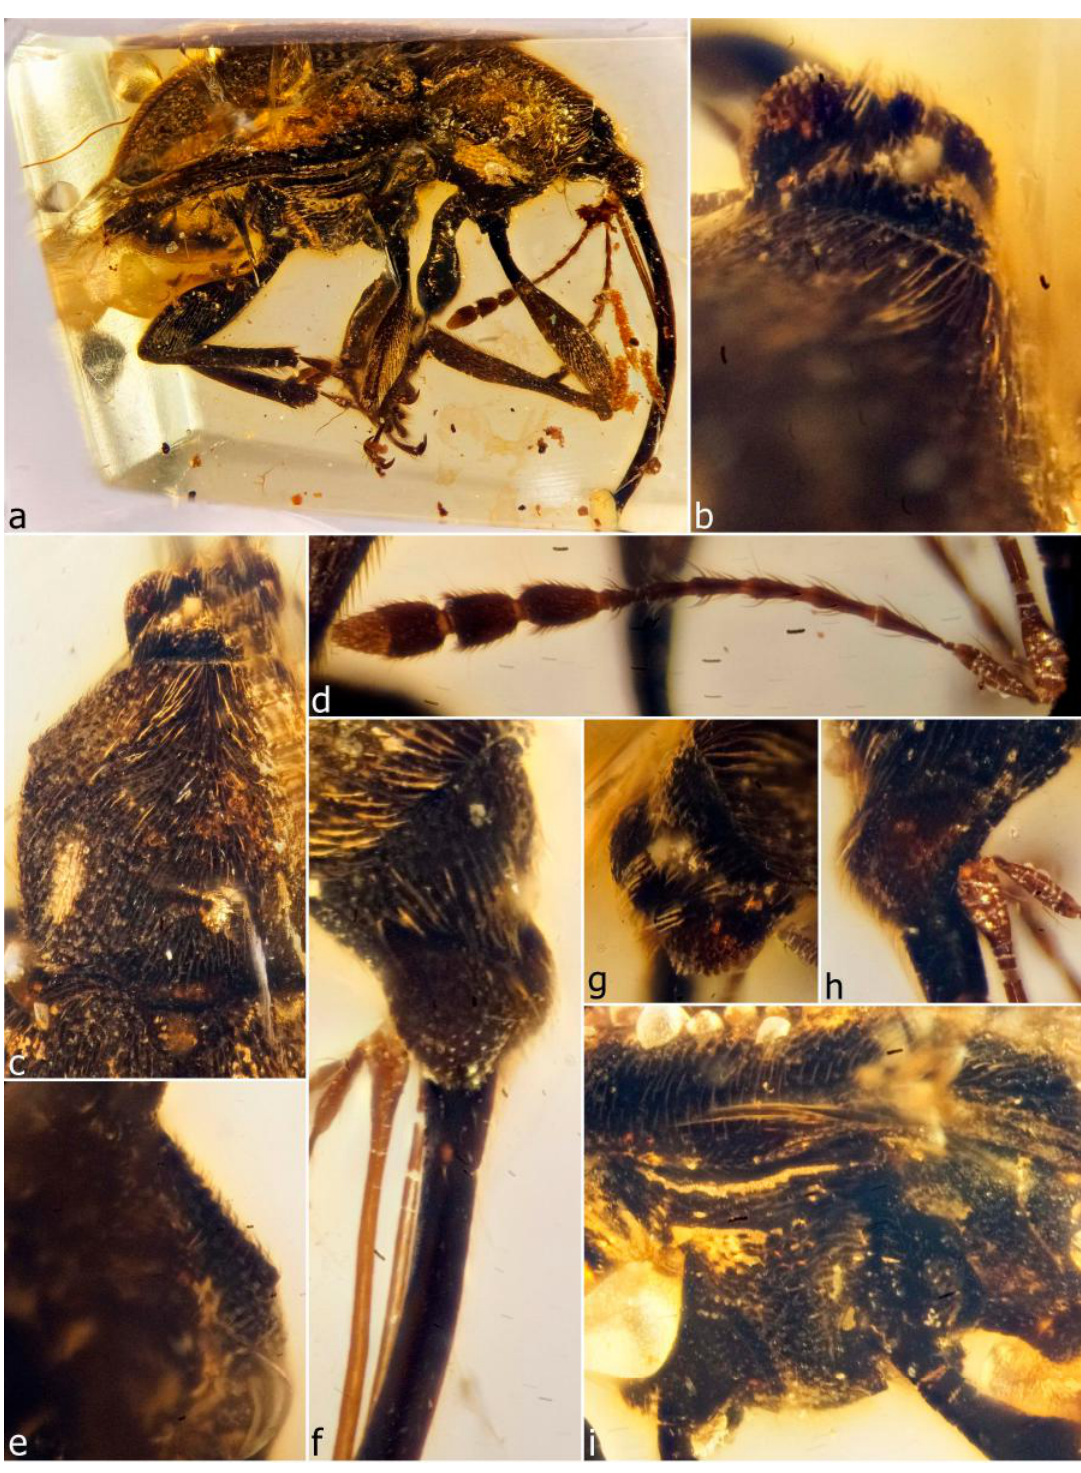
Figure 56. Mekorhamphus gyralommus . Habitus, right lateral ( a ); head showing tubercles and setal tufts between eyes, dorsoposterior ( b ); pronotum showing lateral denticle, dorsal ( c ); left funicle and club, left lateral ( d ); detail of pronotal denticle, dorsal ( e ); head, right dorsolateral ( f ); head, showing detail of tubercles and setal tufts, dorsolateral ( g ); eyes, left lateral ( h ); metathorax, left lateral ( i ).